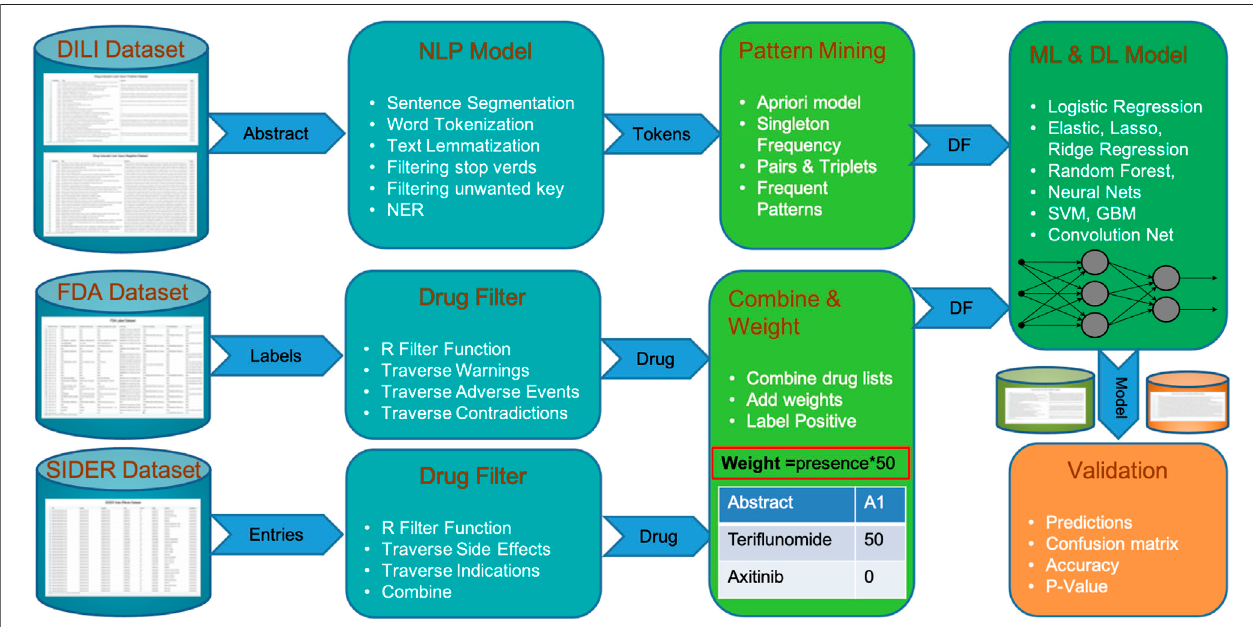
FIGURE 1 | Steps of DILI C from a dataset of DILI-positive and DILI-negative articles to validations showing integration of FDA and SIDER datasets.